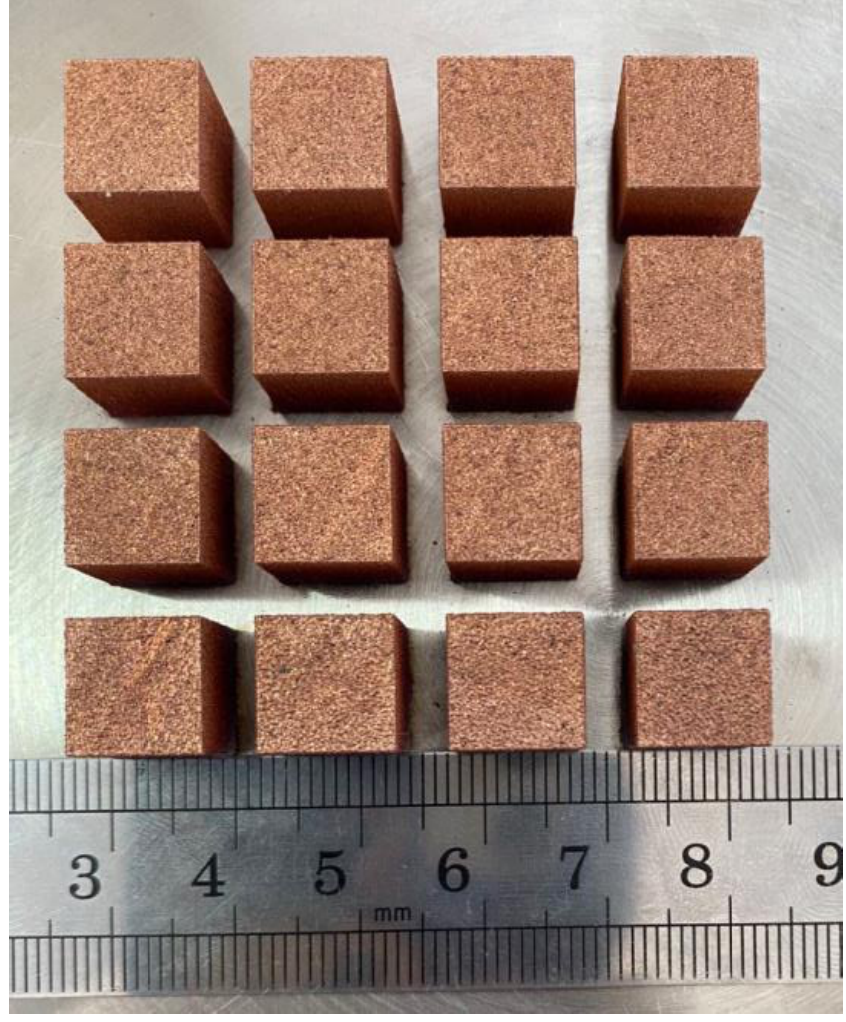
Figure 3. CuCrZr samples fabricated by SLM.